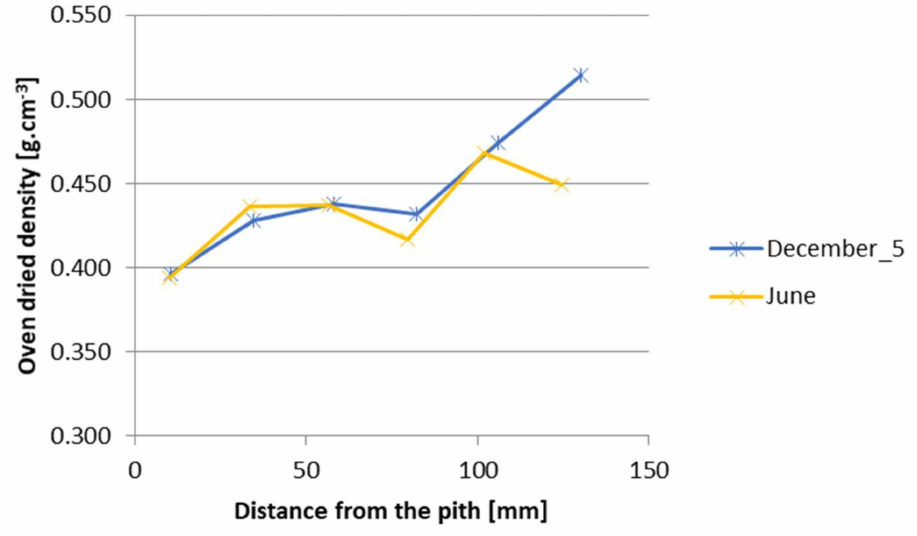
Figure 5. The change in the density in a dry state of parallel figures after the 6-month-long storage. After completing the Equations (4) and (5) with the measured data in a dry state and the position of the parallel figures, the value of DML of the spruce roundwood after the 6-month-long storage was 4.5%. Only a small amount of 0.37% was the loss of the mass of cytoplasm of living cells in the sapwood of the freshly logged spruce wood [9]. A